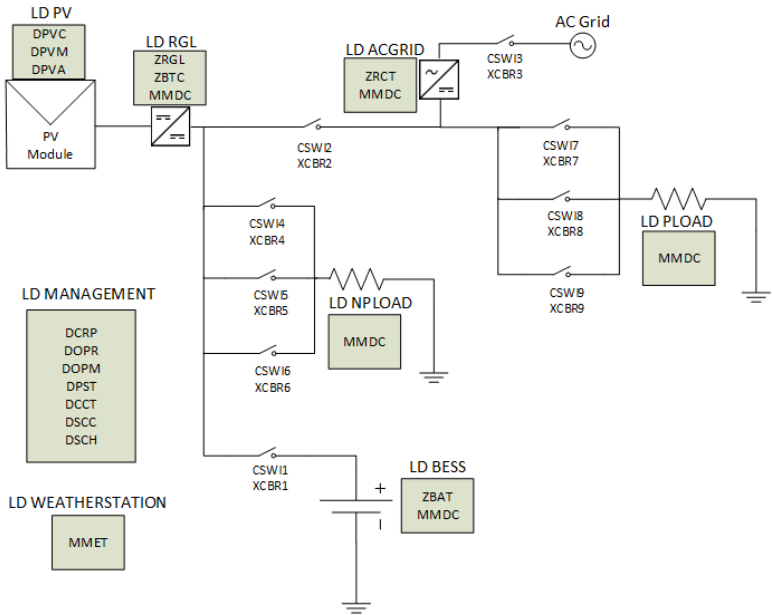
Figure 11. Plant model of the MG-based BTS.